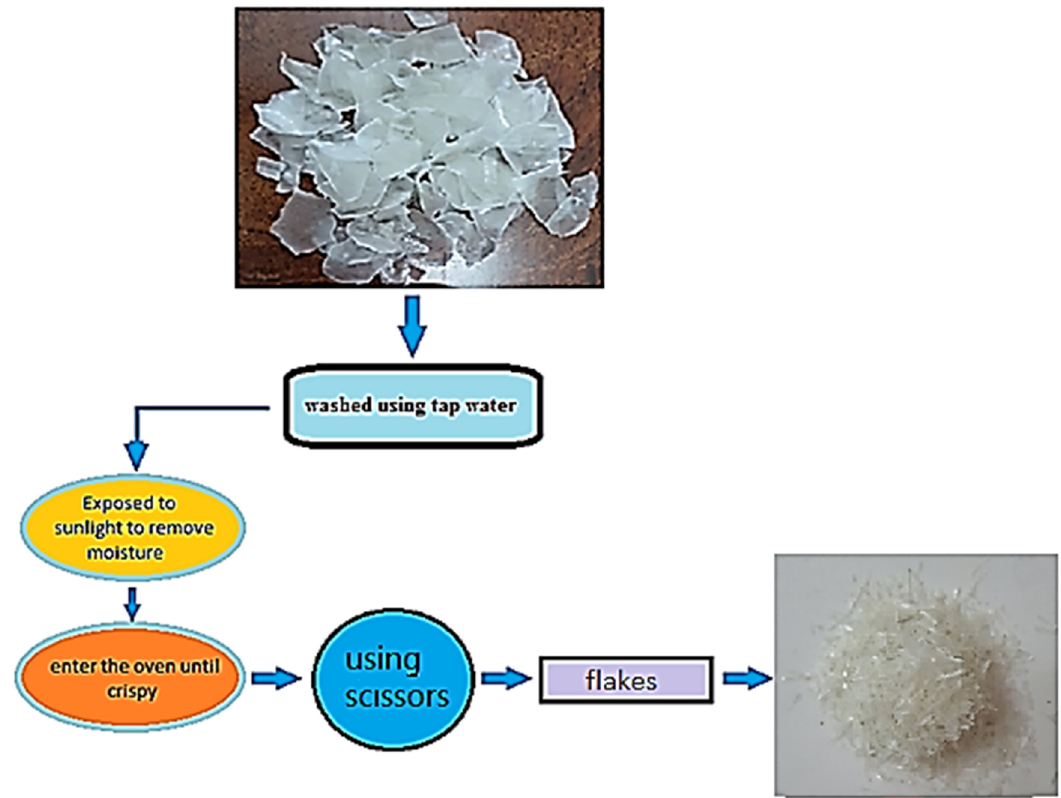
Figure 2: Preparation of fi sh scale fl